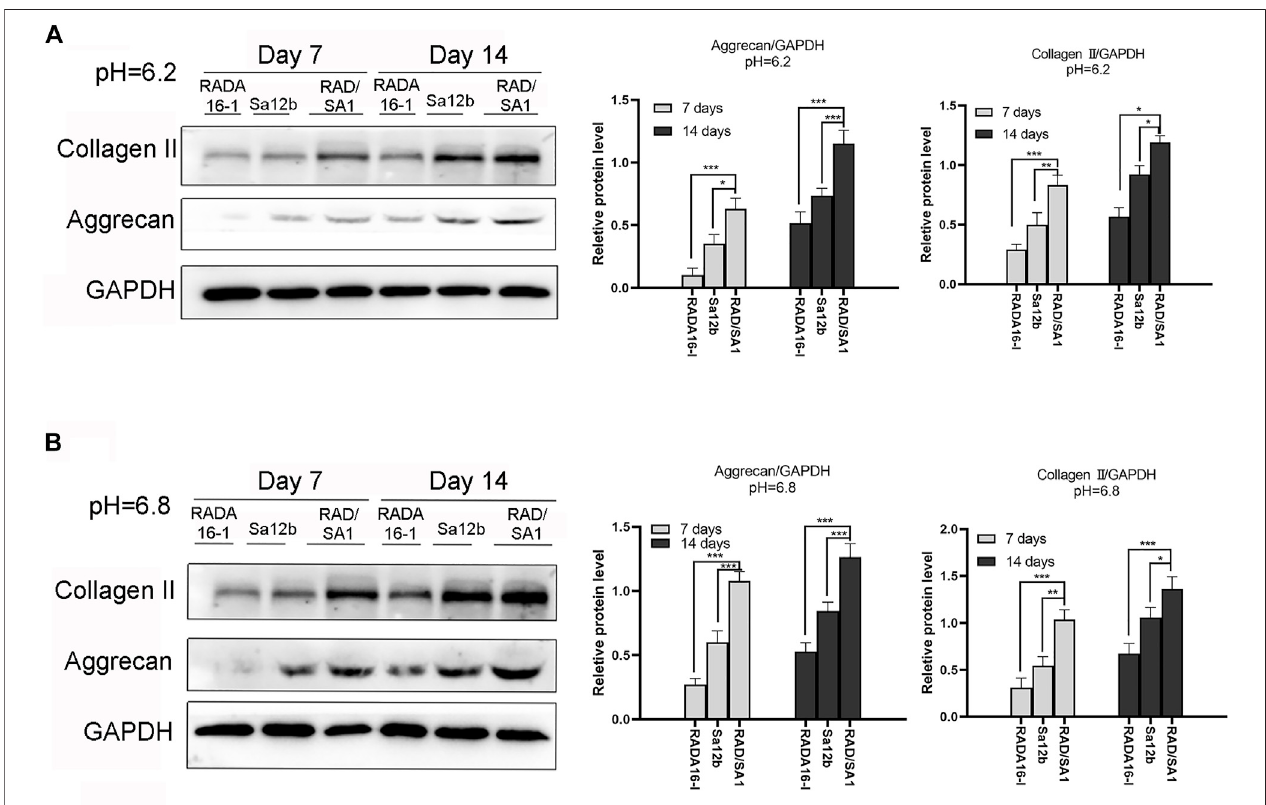
FIGURE 7 | Western blotting revealed that the amounts of collagen II and aggrecan secreted by hNPMSCs were signi fi cantly different among the three groups (RAD/SA1,Sa12bandRADA16-I)after7and14 days,respectively. (A) hNPMSCswereculturedatpH6.2. (B) hNPMSCswereculturedatpH6.8.Whenthetwogroups compared, * indicates p < 0.05, ** indicates p < 0.01, and *** indicates p < 0.001.